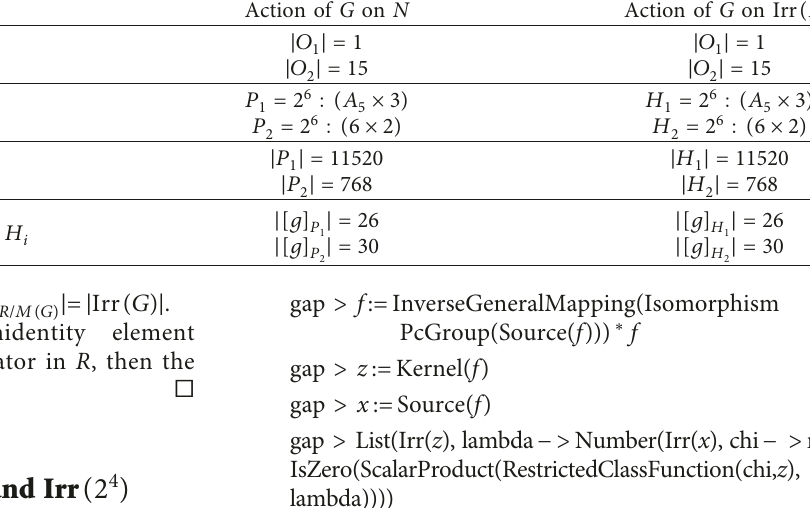
Table 1: Action of G on N and Irr ( N ) . Action of G on N Action of G on Irr ( N